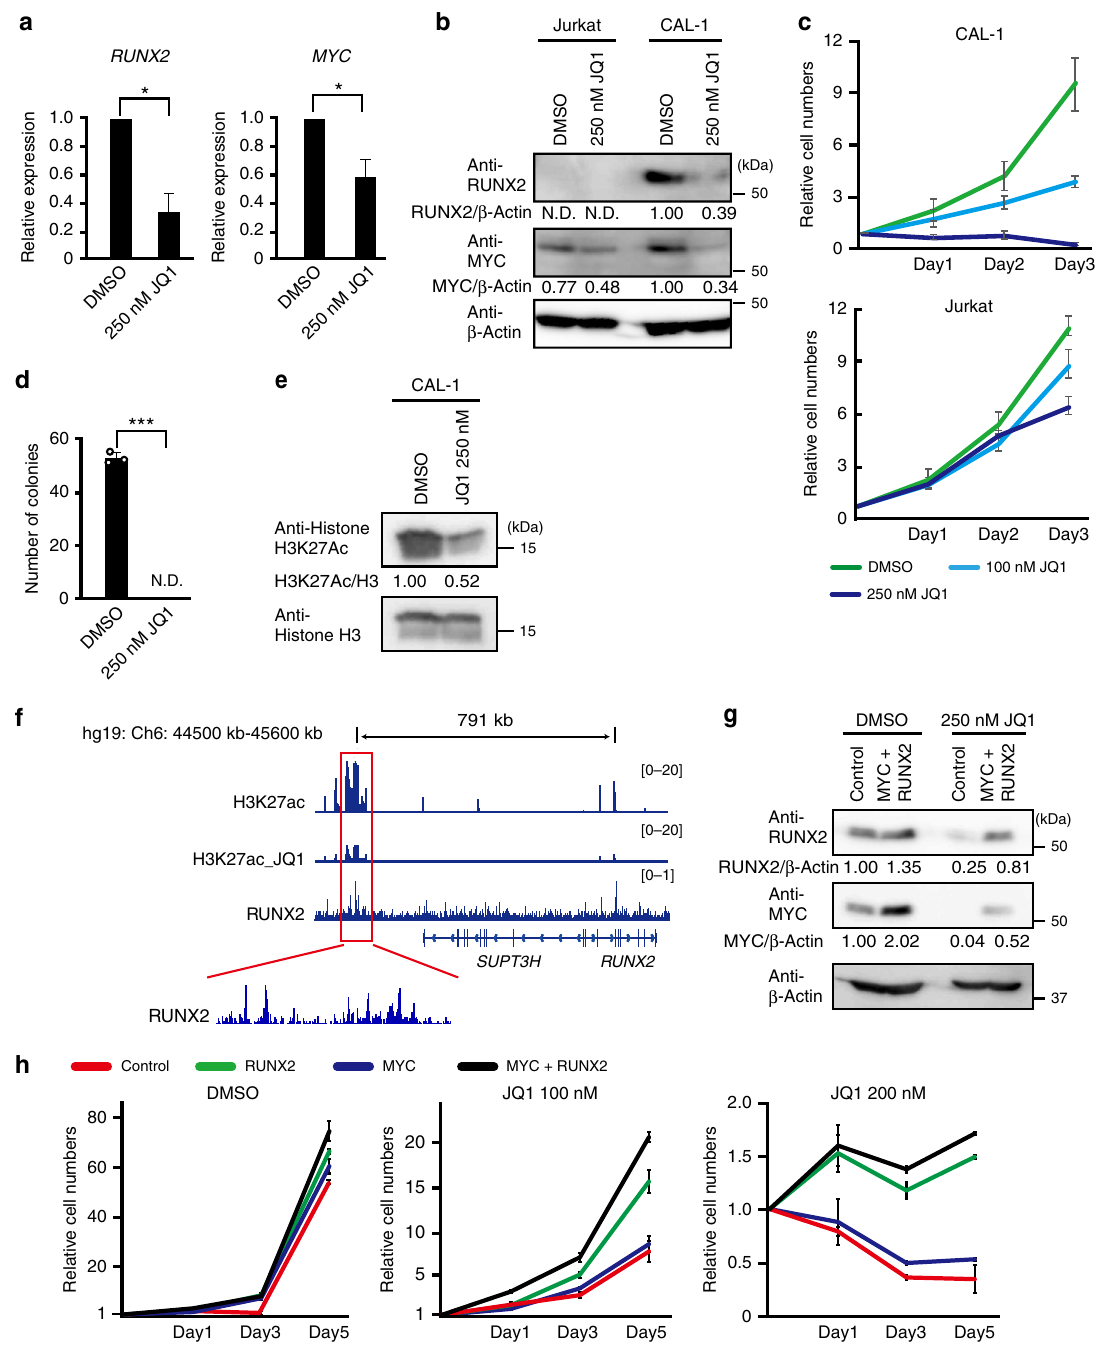
Fig. 4 MYC and RUNX2 promote the formation of BPDCN by activating the function of enhancers. a Expression levels of RUNX2 and MYC mRNA examined by q-PCR in CAL-1 cells 1 day after the 250 nM JQ1 treatment ( n = 3). b CAL-1 cells showing reduced levels of the RUNX2 and MYC proteins 1 day after the 250 nM JQ1 treatment. Levels of β -Actin were used as loading controls. c Decreased cell growth capacities in CAL-1 cells after the JQ1 treatment at 100 nM (light blue line) and 250 nM (blue line) from that in cells treated with DMSO (green line), but not in Jurkat cells ( n = 3). d Impaired colony formation capacities of CAL-1 cells treated with 250nM JQ1 from that in cells treated with DMSO ( n = 3). e Decreased level of H3K27ac expression in CAL-1 cells 1 day after the 250 nM JQ1 treatment. f RUNX2 binding to the super-enhancer of RUNX2 that reduced level of H3K27ac post JQ1 treatment in CAL-1 cells assessed by H3K27ac- and RUNX2-ChIP sequencing. g Successful transduction of RUNX2 and MYC in CAL-1 cells with or without the JQ1 treatment at 250 nM examined by western blotting. Levels of β -Actin were used as loading controls. h RUNX2 alone and RUNX2 plus MYC transductions restoring the impaired cell growth post JQ1 treatment. Empty controls (red lines), RUNX2 alone (green lines), MYC alone (blue lines), and RUNX2 plus MYC vectors (black lines) were transduced in CAL-1 cells, which were then treated with JQ1 at 100 nM and 200 nM under liquid culture conditions ( n = 3). a , c , d , h Bars show the mean±SD, * p < 0.05 and *** p < 0.001 by the Student ’ s t -test. Data are representative of 2 – 3 independent